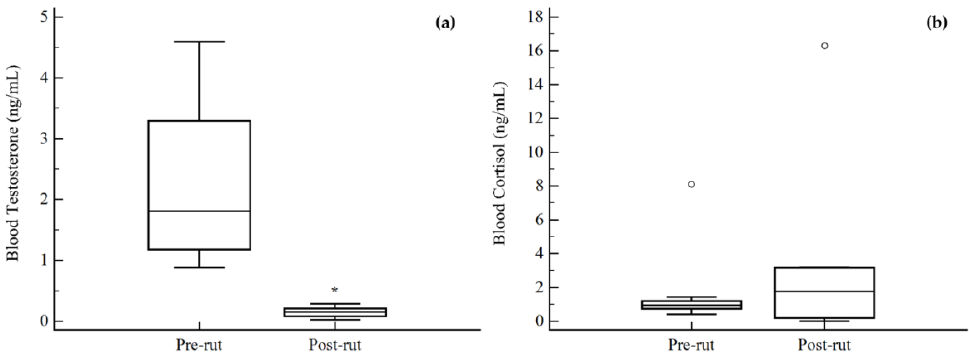
Figure 2. Differences between pre- and post-rut groups for the blood steroid hormone concentrations. ( a ) Testosterone; ( b ) cortisol. ○ outlier; * p < 0.05.